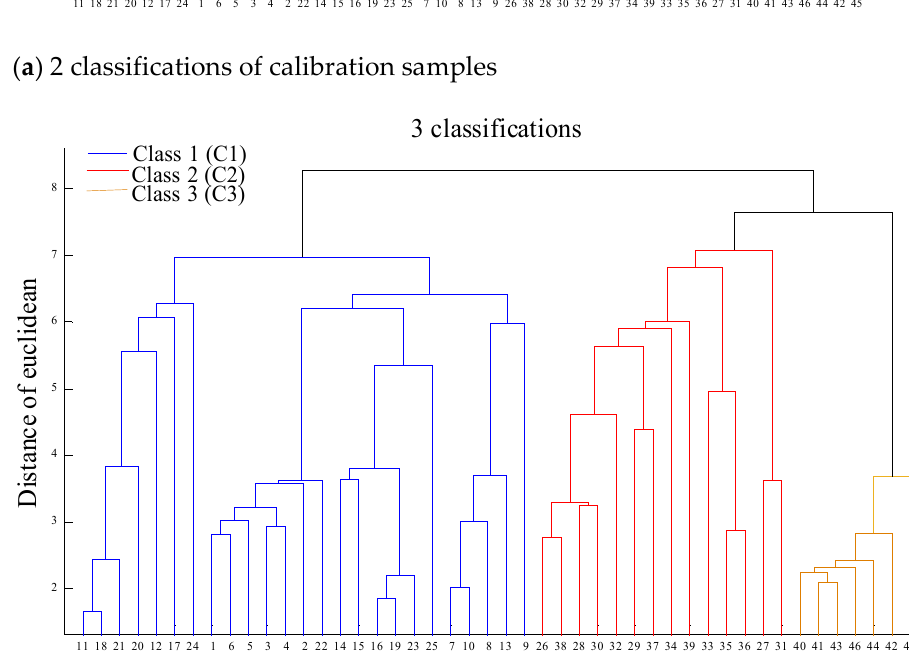
Figure 3. Unsupervised 2 classifications ( a ) and 3 classifications ( b ) hierarchy diagram of calibra- tion samples.